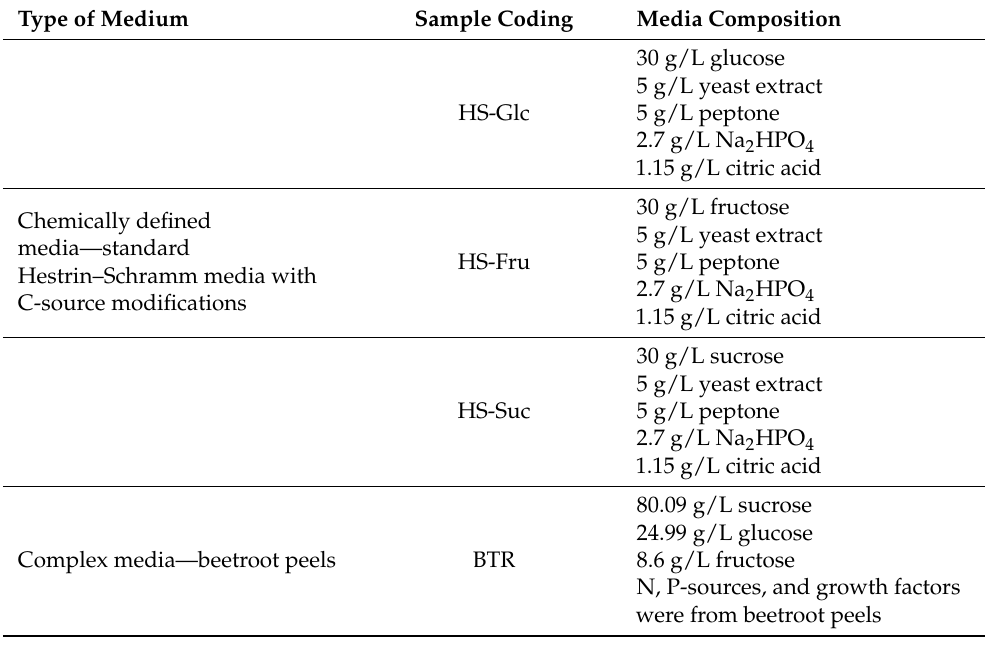
Table 1. BNC production media and sample coding according to the procedure. Type of